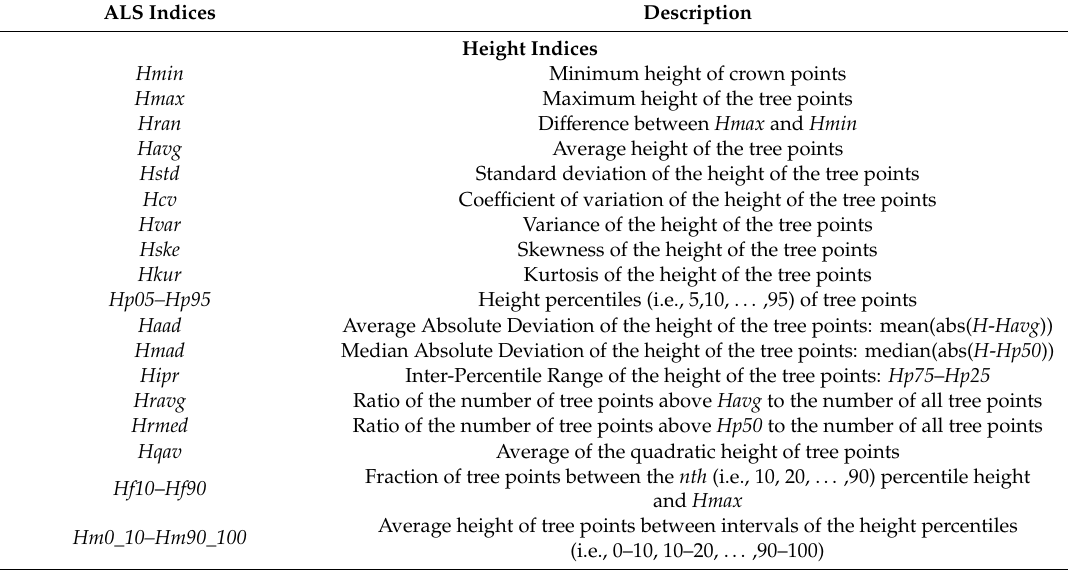
Table 2. Indices calculated from airborne laser scanning point cloud ( H is the height of an individual point, and I is the range-corrected intensity of an individual point).